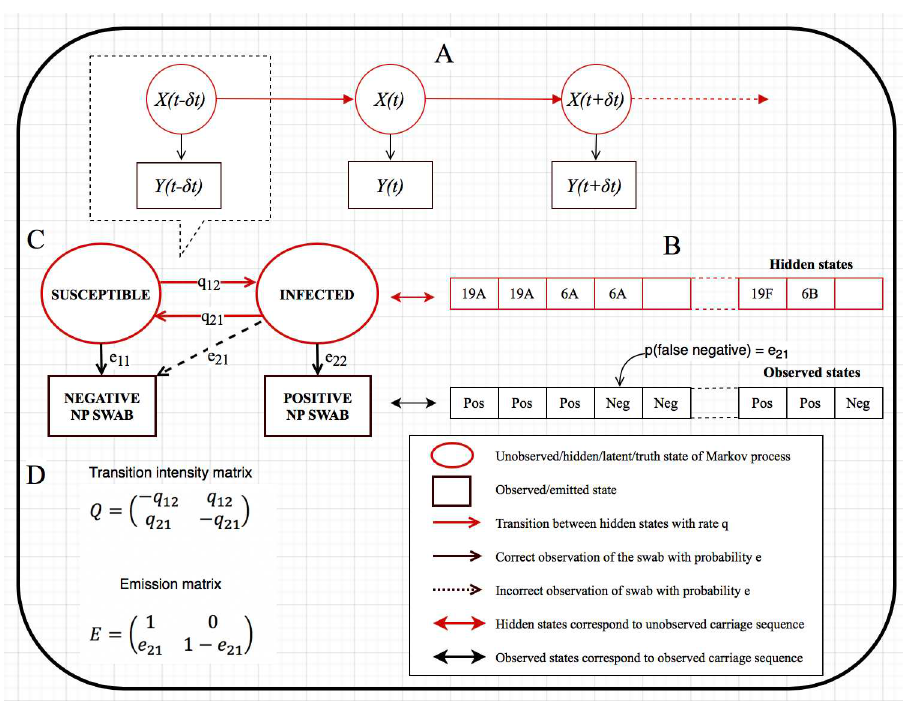
Fig 1. Susceptible-infected-susceptible (SIS) hidden Markov model schemas of pneumococcal carriage dynamics in South African households between 2016–2018. Continuous-time time-homogeneous hidden Markov model where X ( t ) represents hidden states, and Y ( t ) observed states, and in which Y ( t ) is conditionally independent given X ( t ) and the Markov property holds (A). Pneumococcal nasopharynx (NP) carriage sequence of a specified individual representing hidden and observed states, with a probability that an individual truly carrying a pneumococcal serotype may be detected negative by a real-time quantitative polymerase chain reaction test (B). An SIS hidden Markov model structure that captures a snapshot of part A and carriage sequence of part B in order to estimate transition rates and probability of misclassification/false negative (C). Transition intensity matrix, Q, and emission matrix, E, respectively capture the SIS model transition rates and emission or misclassification probability in part C to compute the maximum likelihood estimates of transition intensities and misclassification probability